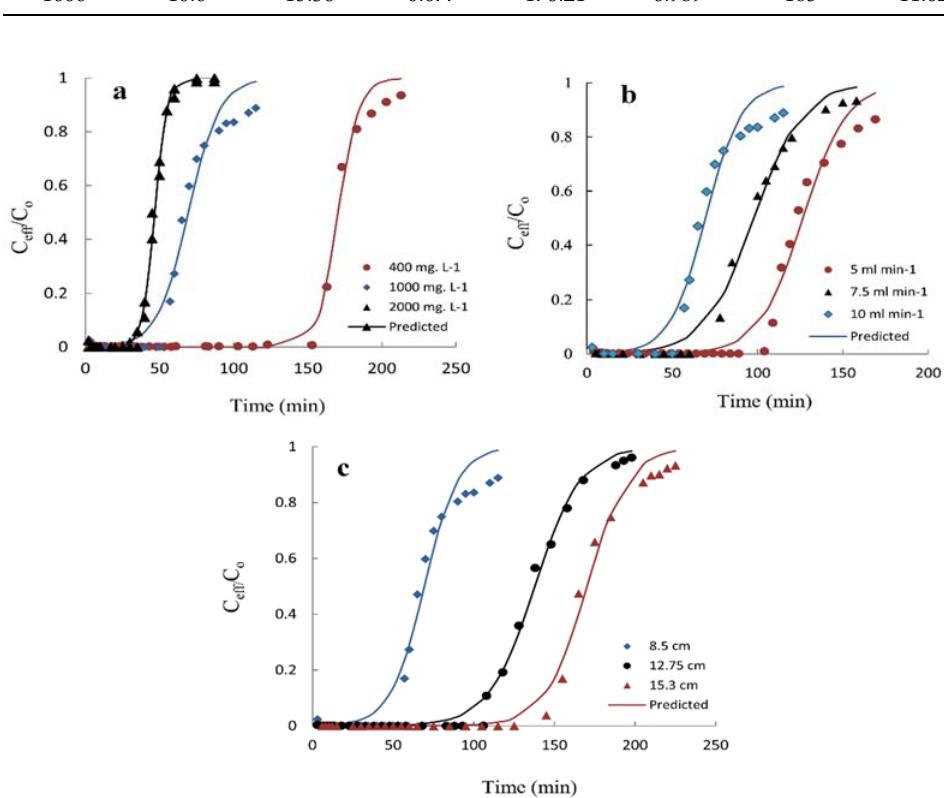
Figure 9. Experimental curves of breakthrough versus the predicted, attained at various ( a ) concentrations of phenol inlet, ( b ) phenol rates of flow, and ( c ) bed depths according to the model of Yoon– Nelson.